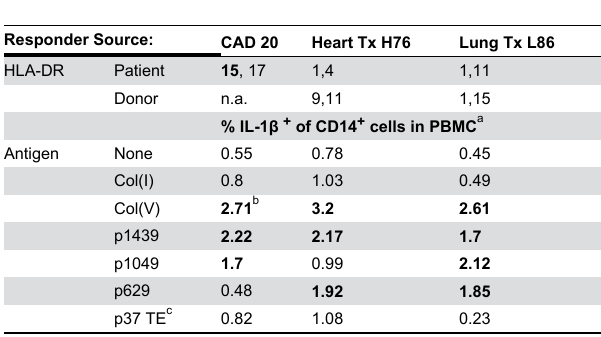
Table 3. Col(V) epitope analysis by induction of IL-1β + in monocytes from PMBC after 24 hour in vitro